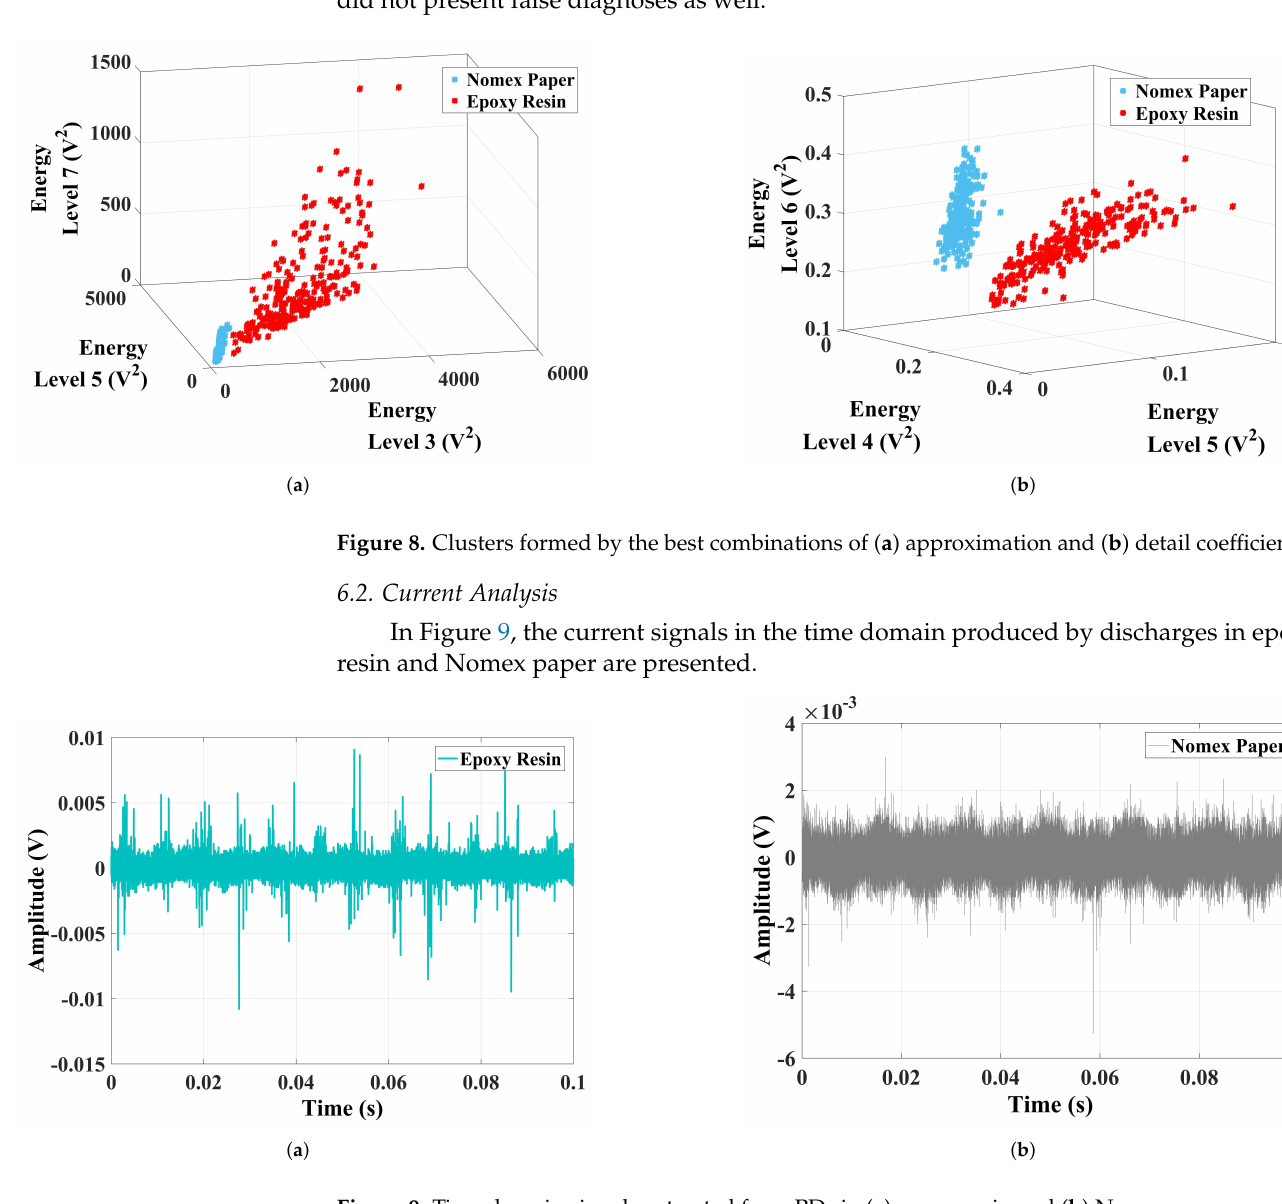
Figure 9. Time domain signals extracted from PDs in ( a ) epoxy resin and ( b ) Nomex